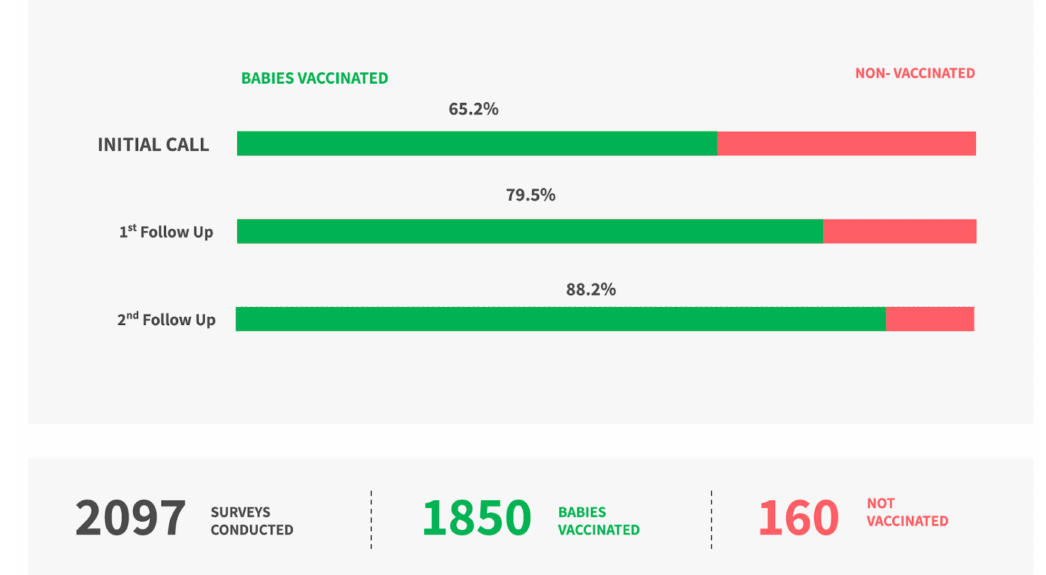
Figure 3. Immunization uptake at the end of the